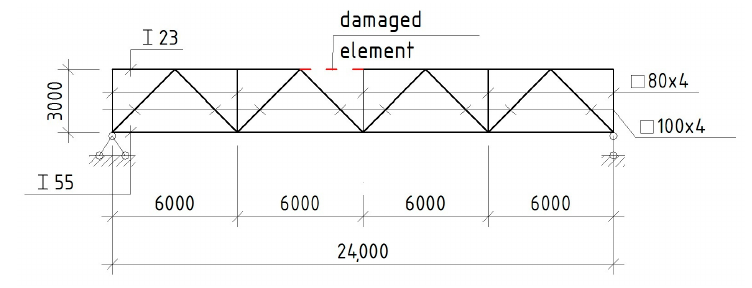
Figure 14. Truss with a damaged upper chord.